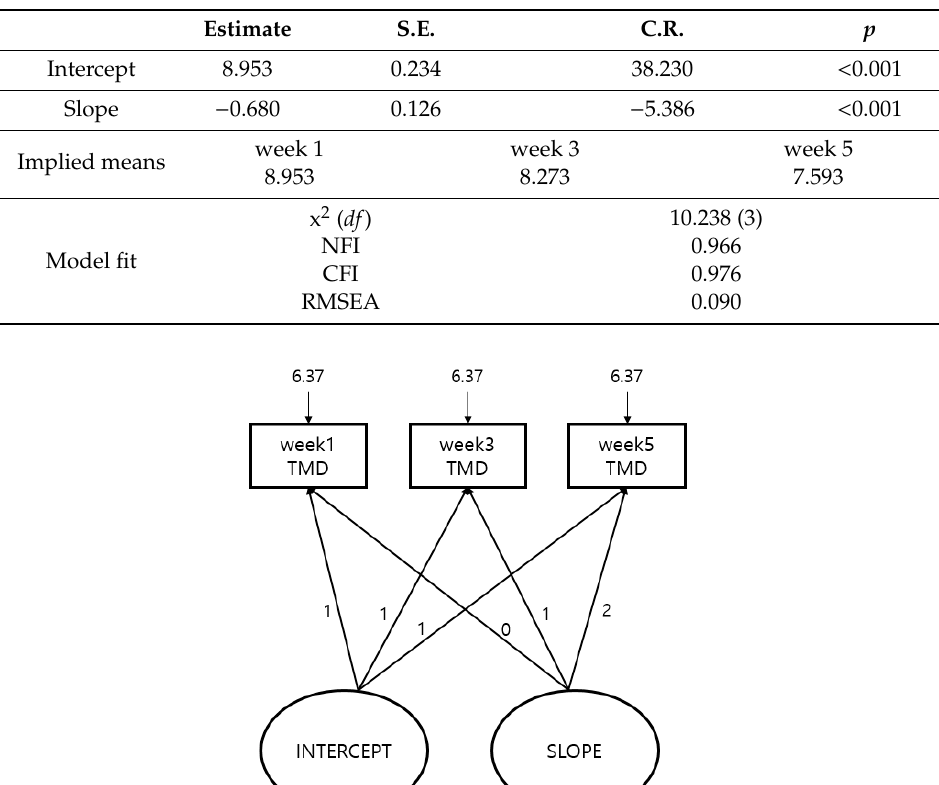
Table 5. Latent growth model analysis of changes in POMS.